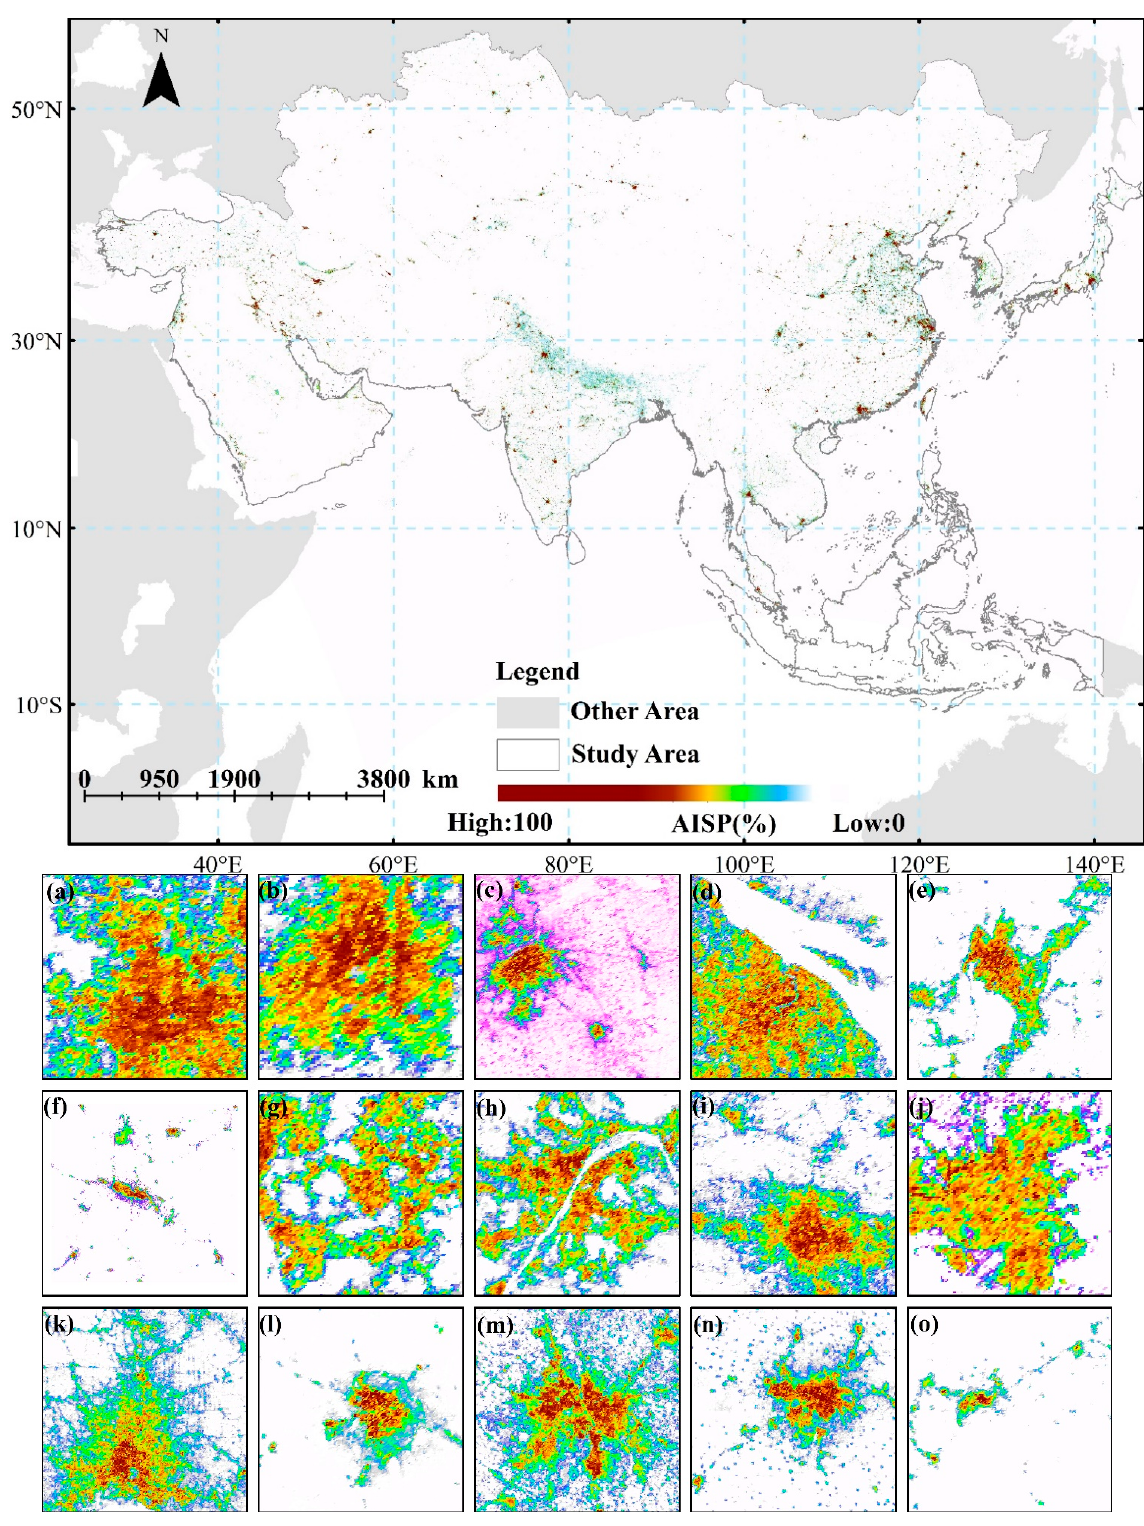
Figure 5. Spatial distribution of artificial impervious surface percentage achieved by scheme 4 using 80% of samples for training in Asia in 2018. ( a ): Beijing, ( b ): Changchun, ( c ): Harbin, ( d ): Shanghai, ( e ): Kunming, ( f ): Lanzhou, ( g ): Shenzhen, ( h ): Wuhan, ( i ): Zhengzhou, ( j ): Urumqi, ( k ): Bangkok, ( l ): Astana, ( m ): New Delhi, ( n ): Ankara, ( o ): Anshun.